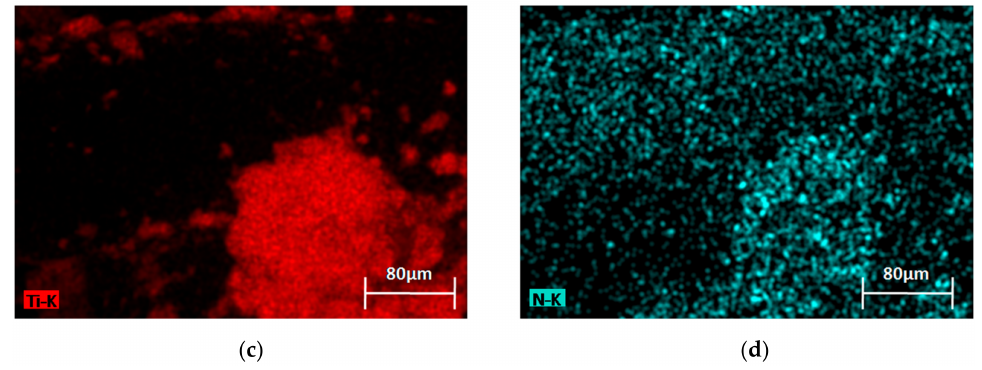
Figure 4. EDX mapping of RGO / TiO 2 coated PA (( a )- map of the C element, ( b )- map of the O element, ( c )- map of the Ti element, ( d )- map of the N element).